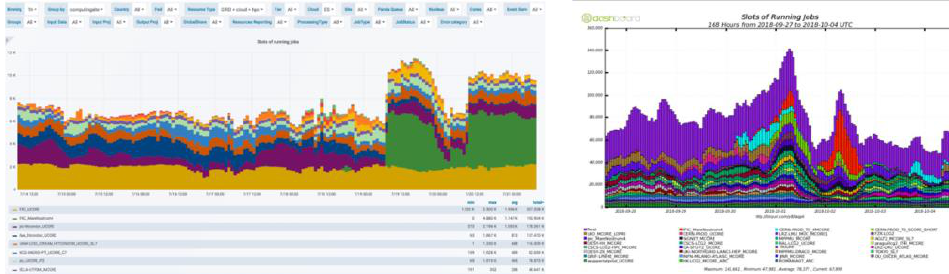
Fig. 4. Left: Impact of the start of MN4 (green) in the Spanish cloud. Right: MN4 HPC (red) resource utilization running ATLAS simulation jobs in October